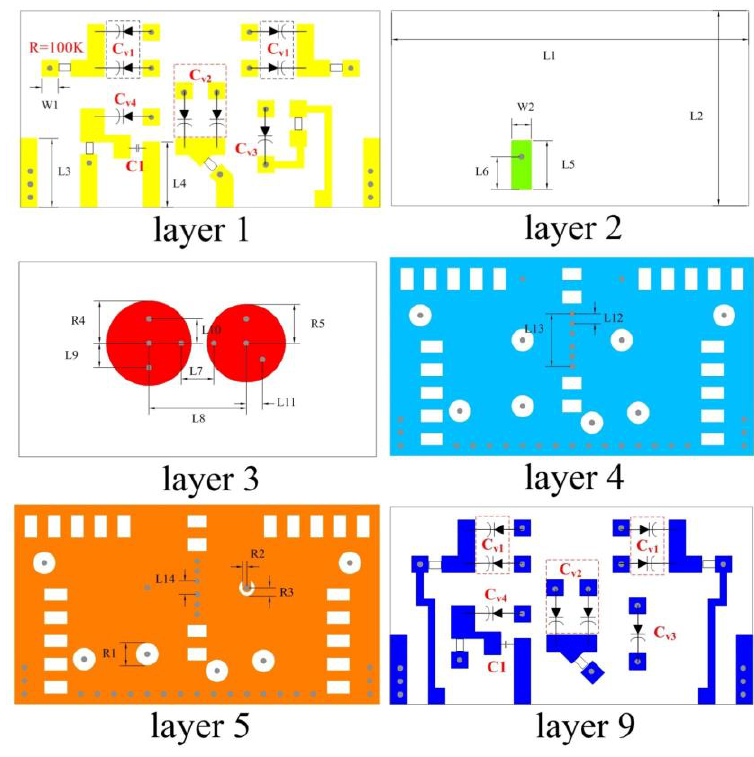
Figure 10. Layouts of the proposed LTCC filter. Table 1. The dimensions (mm) of the designed filter.